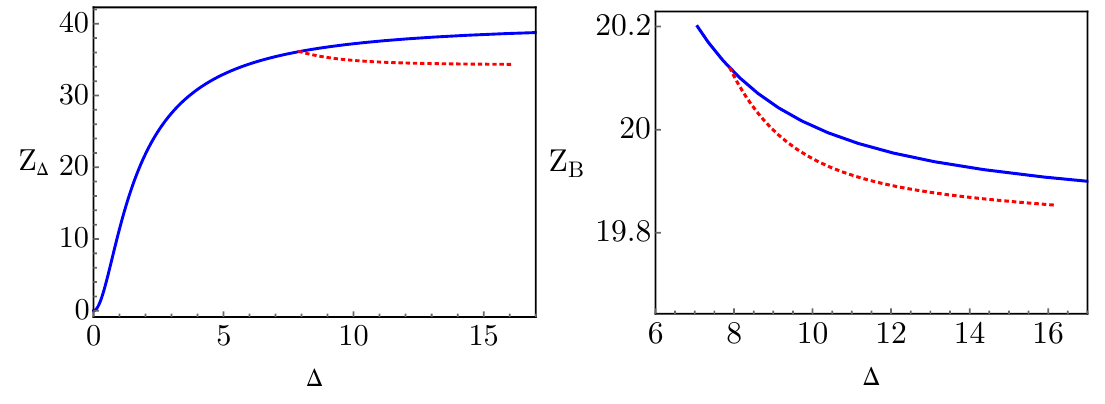
Figure 7 . Anomalous transport coe(cid:14)cients Z (cid:1) (at (cid:22) = 1 = 2) and Z B (at (cid:22) 3 = 1 = 2) as a function of (cid:1). The blue (dashed red) line corresponds to the mWSM ( xy nematic condensate)